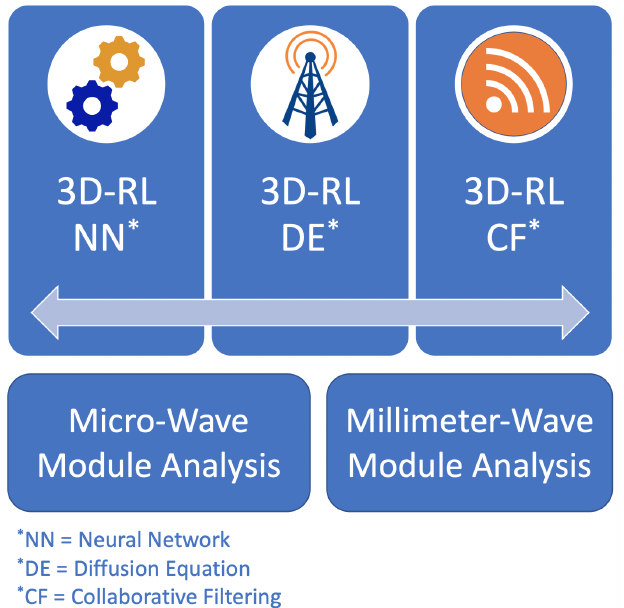
Figure 3. Schematic view of the 3D-RL implemented modules with the combination of hybrid techniques to reduce the computational load. Different material properties and propagation phenomena are considered in the different modules based on the frequency under